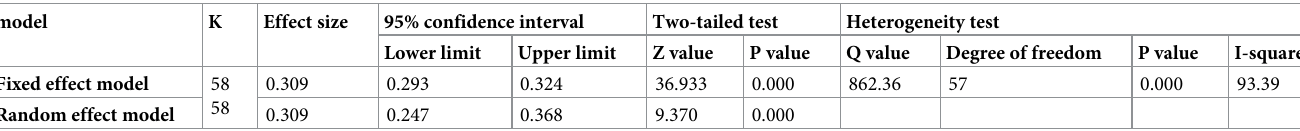
Table 1. Heterogeneity test